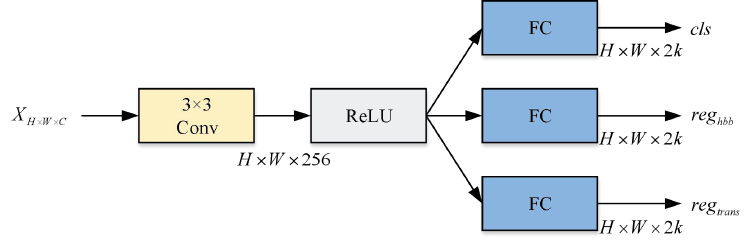
Figure 5. Description of the oriented region proposal